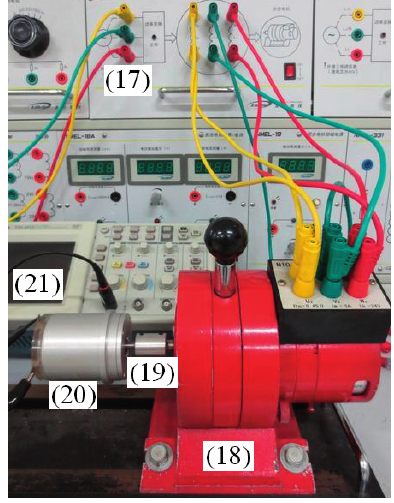
Figure 20. Connection diagram of step motor angular acceleration testing. ( f = 702 Hz).